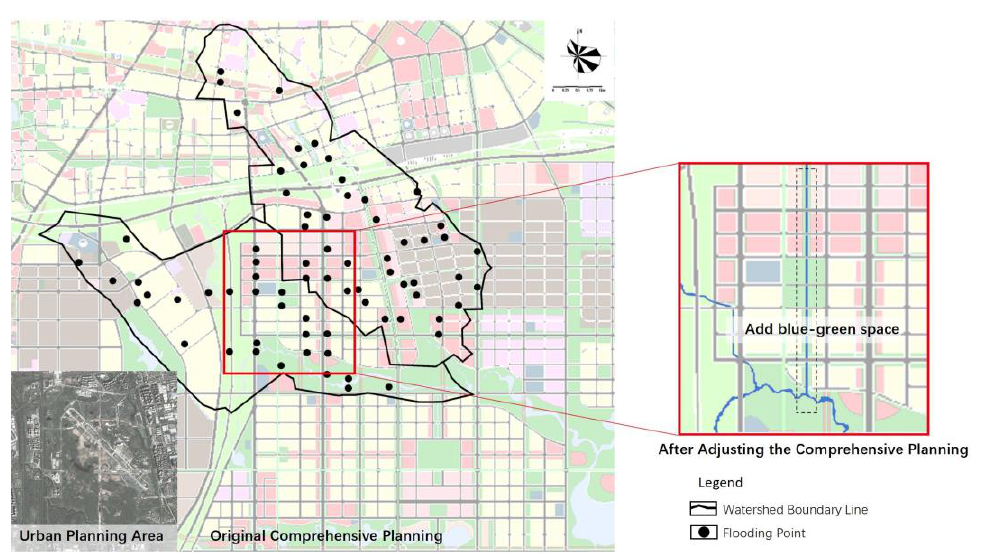
Figure 9. Planning Figure 9. Planning modification.